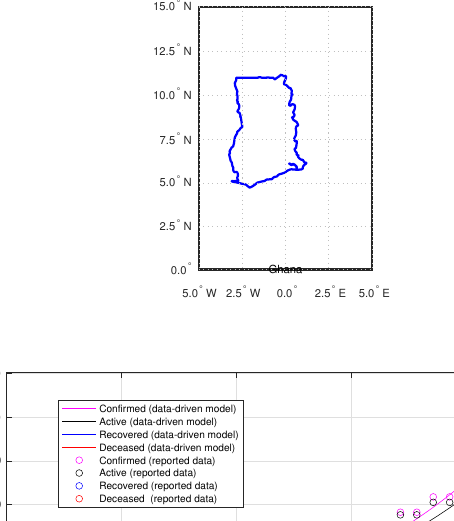
Confirmed (data-driven model) Active (data-driven model) Recovered (data-driven model) Deceased (data-driven model) Confirmed (reported data) Active (reported data) Recovered (reported data) Deceased (reported data)